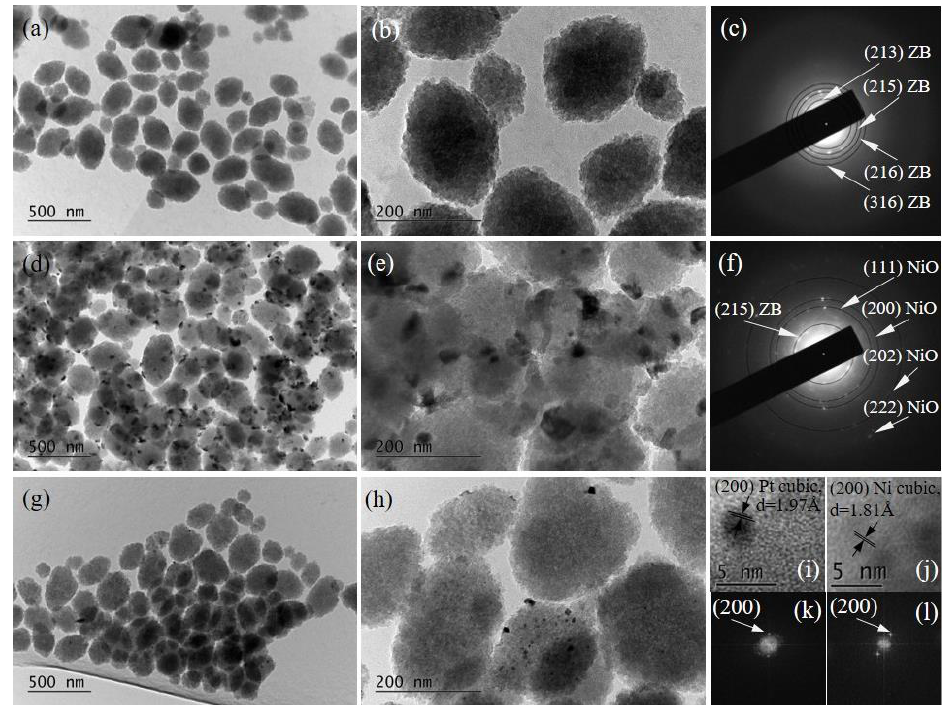
Figure 4. Bright Field TEM (BFTEM) images of zeolite Beta ( a , b ), 10Ni1Pt/HB ( d , e ) and 5Ru1Pt/HB ( g , h ). SAED patterns of zeolite Beta ( c ) and 10Ni1Pt/HB ( f ). HRTEM images and the corresponding Fast Fourier Transform (FFT) patterns of 10Ni1Pt/HB ( j , l ) and 5Ru1Pt/HB ( i , k ) samples.